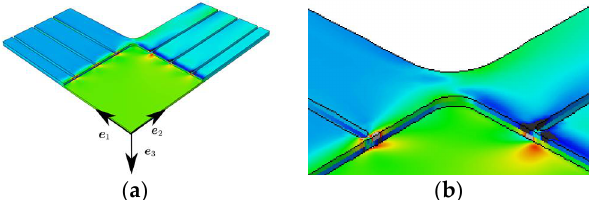
Figure 6. ( a ) FE results for equi-biaxial load at a displacement of the specimen arms of 0.2 mm, largest principal strain (cid:2013) (cid:2869) ( b ) Detail from ( a ).